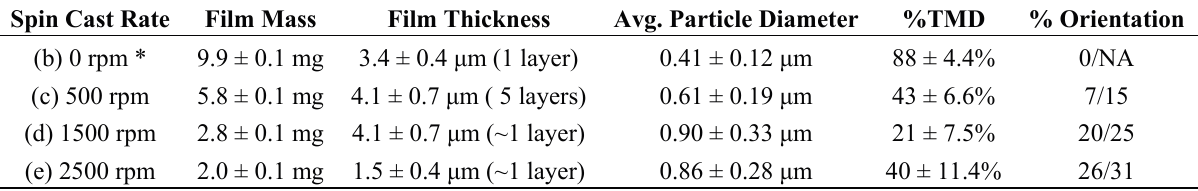
Table 1. Summary of the properties of drop and spin cast films of HI 3 O 8 particles. % Orientation is the fraction of the crystals that have their ac crystal plane oriented parallel to the surface (denatured ethanol/ethanol films).